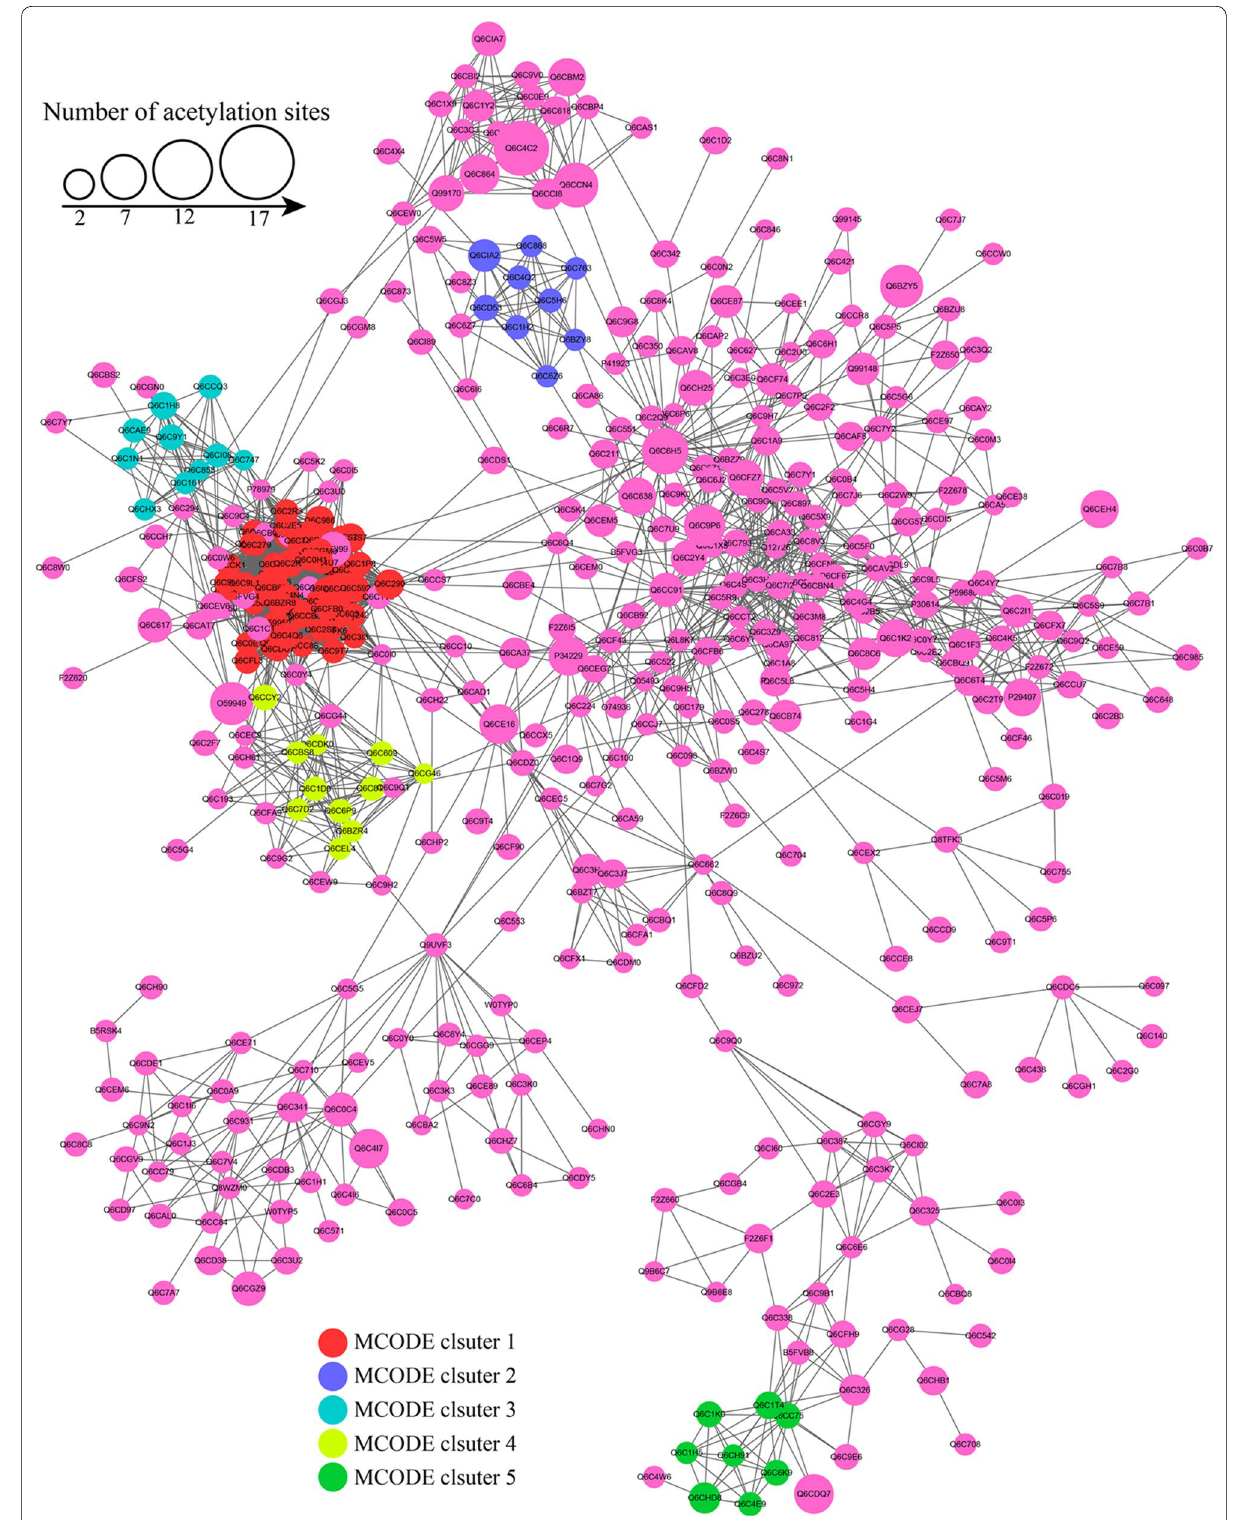
Fig. 10 Interaction networks of the acetylated proteins in oleaginous yeast. Interaction networks of all acetylated proteins with the top five clusters of proteins associated with ribosome ( red ), aminoacyl-tRNA biosynthesis ( blue ), RNA transport ( light blue ), ribosome biogenesis in eukaryotes ( light green ) and oxidative phosphorylation ( green